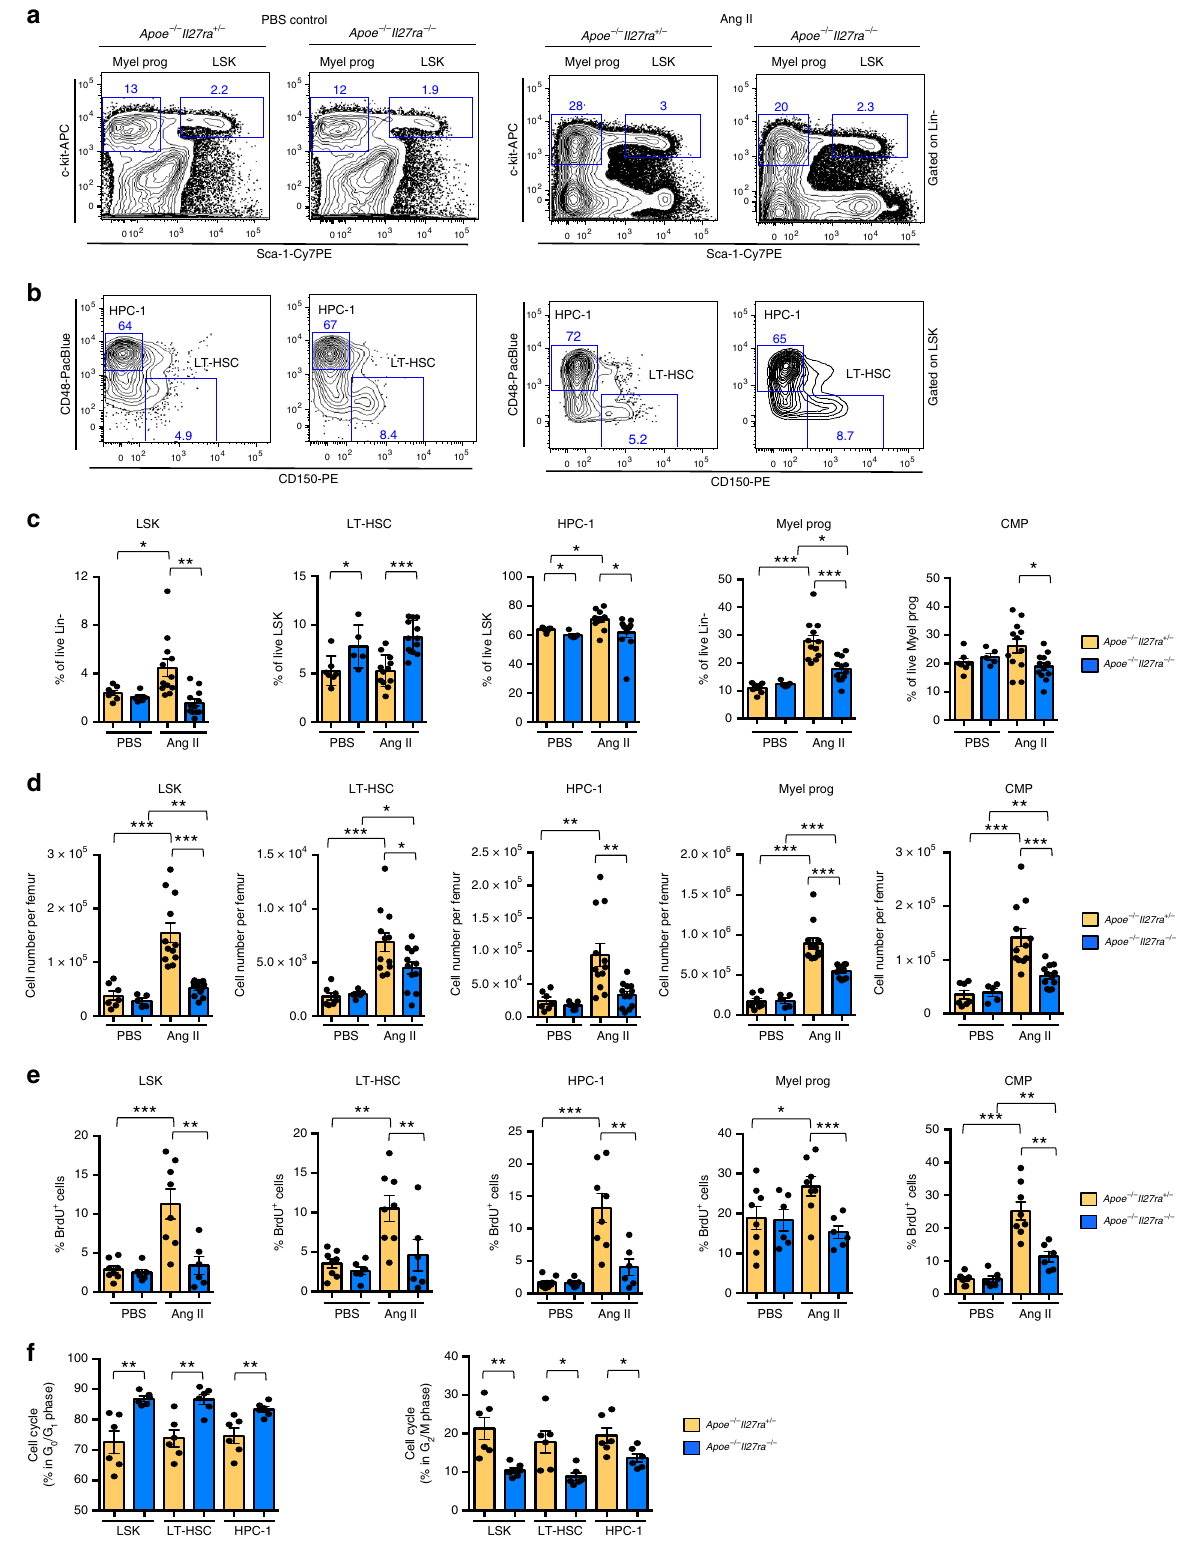
blood in comparison with IL-27R-suf fi cient Apoe − / − (CD45.1) cells from the same recipient mice (Fig. 5f, g). Of note, the number of circulating myeloid cells of IL-27R-suf fi cient origin was elevated in response to Ang II infusion compared with PBS